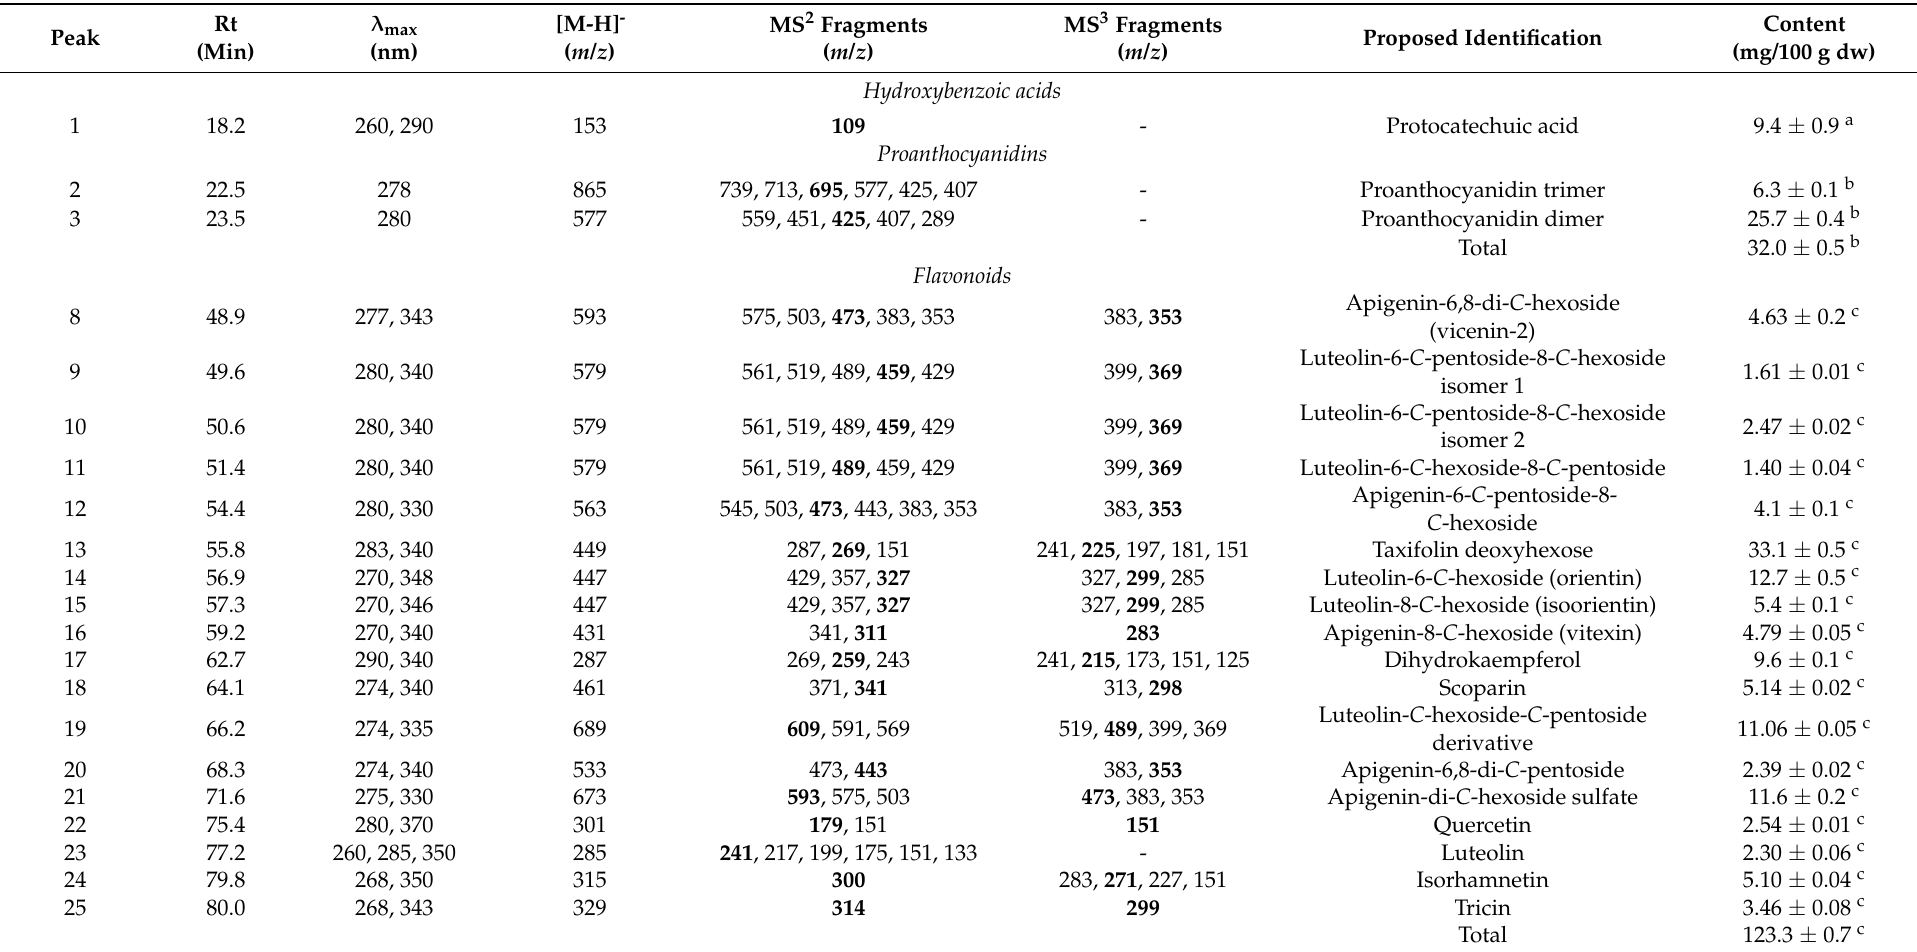
Table 2. Retention time, maximum absorbance wavelengths and main fragments of non-anthocyanin phenolic compounds tentatively assigned in AHE by HPLC-DAD-ESI-MS n , in negative ionization mode. The content of phenolic compounds was determined in mg/100 g dw and expressed as mean ±